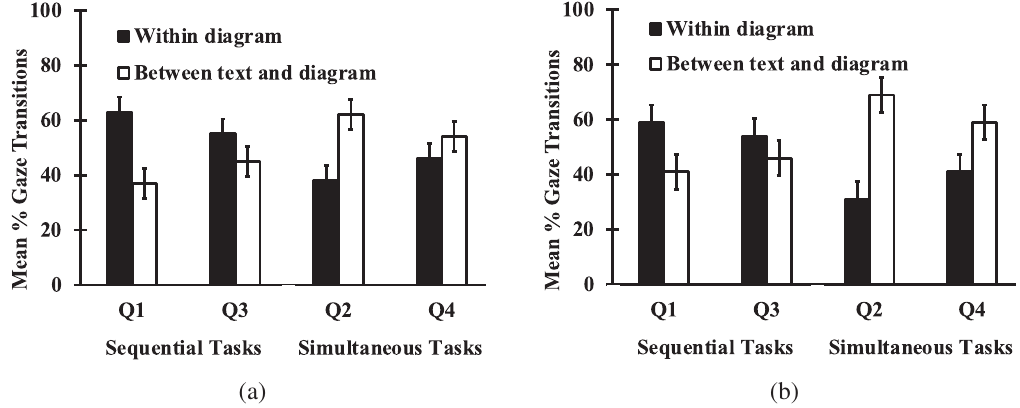
FIG. 4. Mean percentages of gaze transitions ( (cid:2) standard error) within diagram, and between text and diagram for the (a) thinking phase and (b) talking phase.